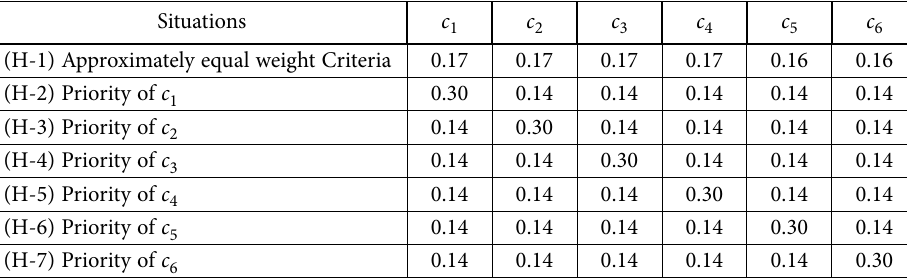
Table 15. Criteria’s weights assignment Situations c